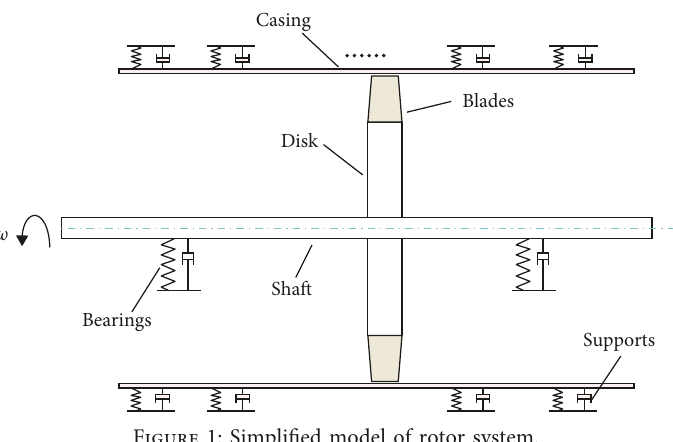
Figure 1: Simplified model of rotor